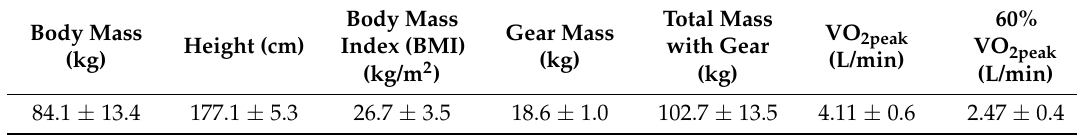
Table 1. Participant descriptive characteristics ( n =